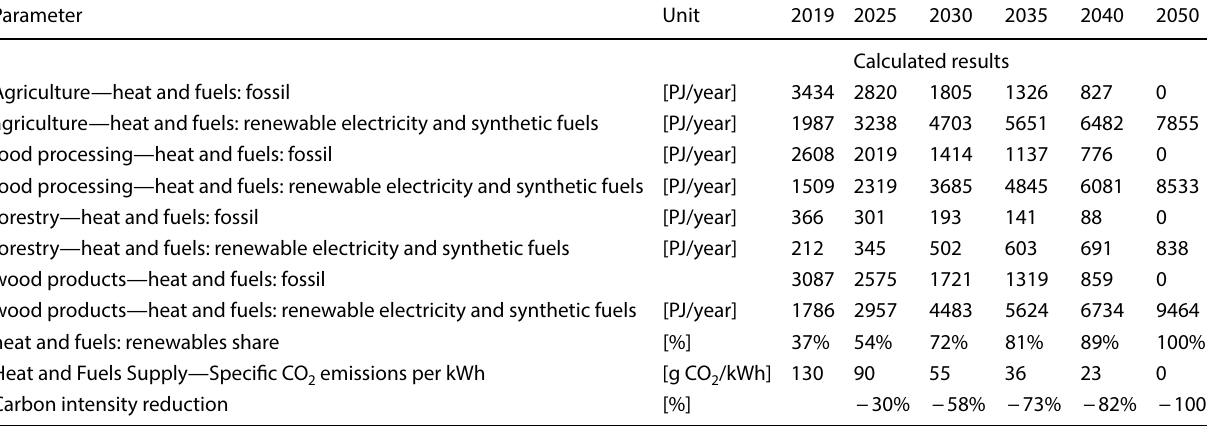
Table 15 Results: heat and fuel supplies for the analysed sectors under the 1.5 °C energy pathway Parameter